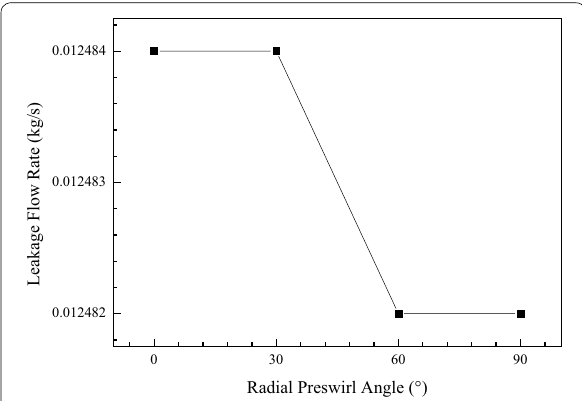
Figure 8 Leakage flow rate versus radial pre-swirl angle